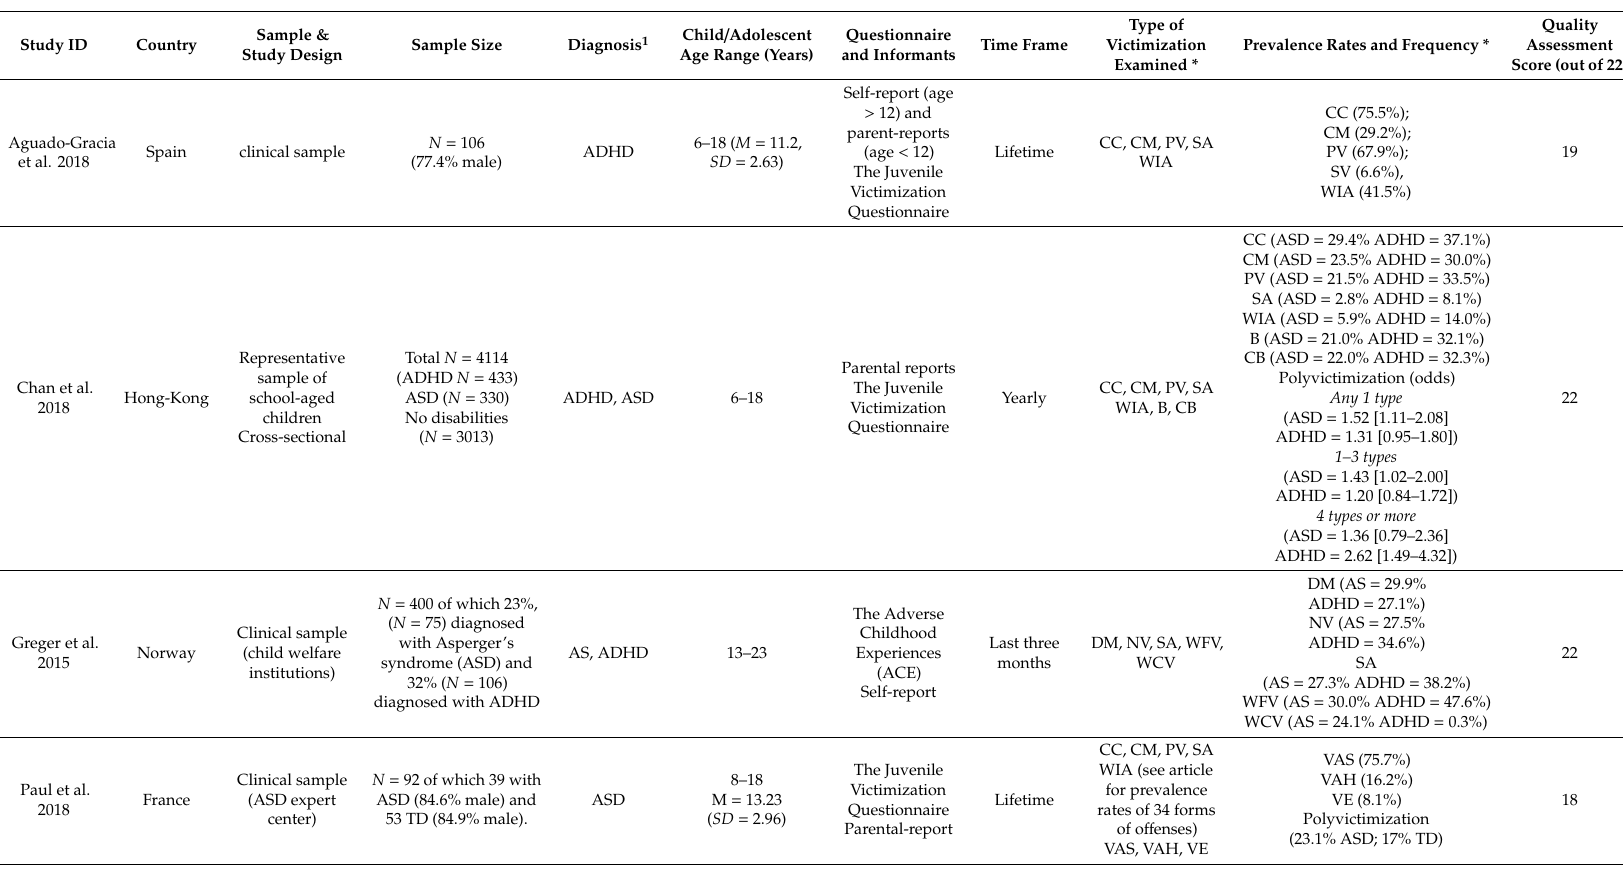
Table 1. Summary of findings of polyvictimization among children and adolescents with Autism Spectrum Disorder or Attention Deficit / Hyperactivity